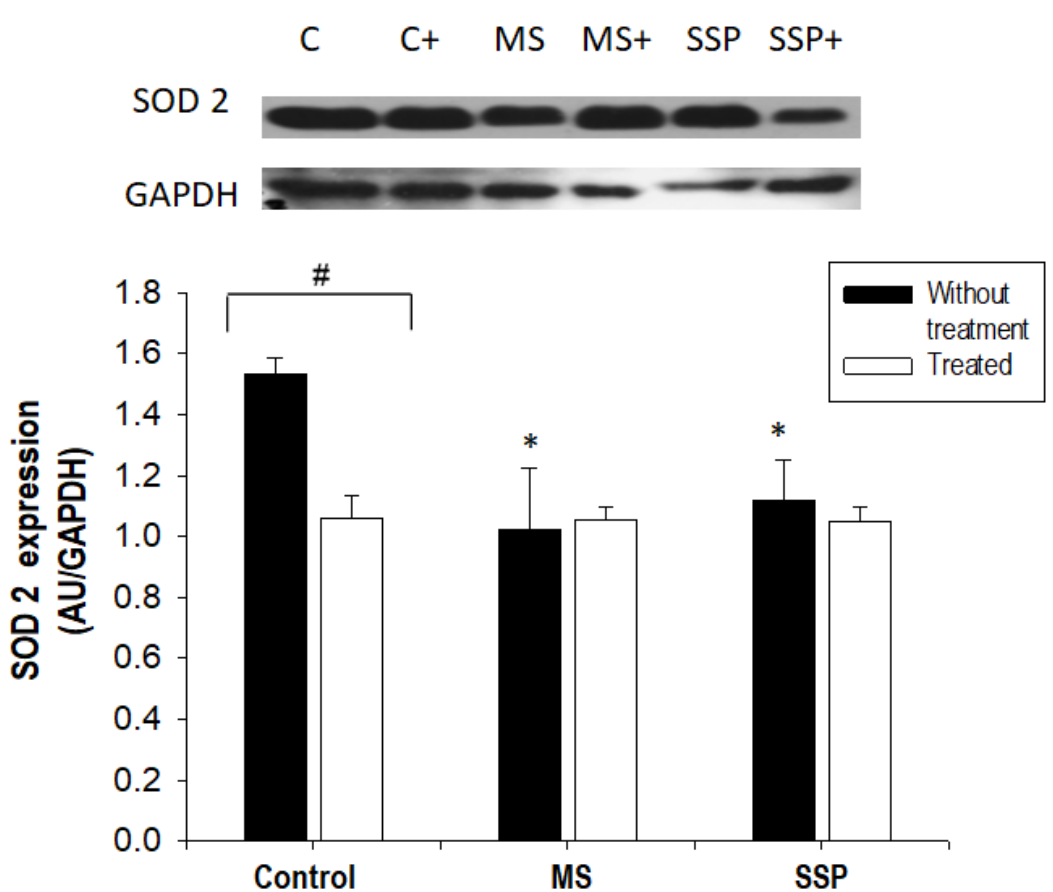
Figure 7. The effects of the administration of RSV plus QSC on SOD 2 expression in the aorta homogenate. A representative Western blot image is shown. Data represent the mean ± SEM of five different rats from each group. # p < 0.01; * p < 0.05 against C group without treatment (after one-way ANOVA). Abbreviations: C = control; C+ = control treated with polyphenols; MS = metabolic syndrome; MS+ = metabolic syndrome treated with polyphenols; SSP = short sucrose period; SSP+ = short sucrose period treated with polyphenols.